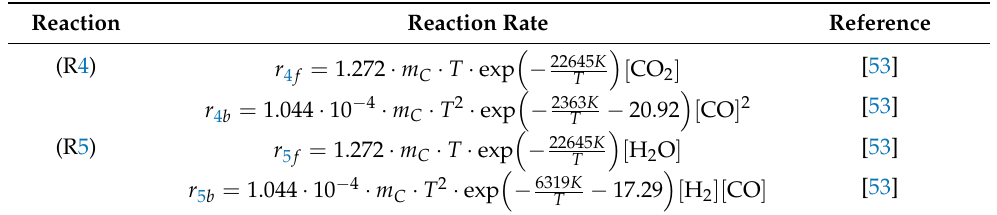
Table 3. Reaction kinetics of the homogeneous reactions.